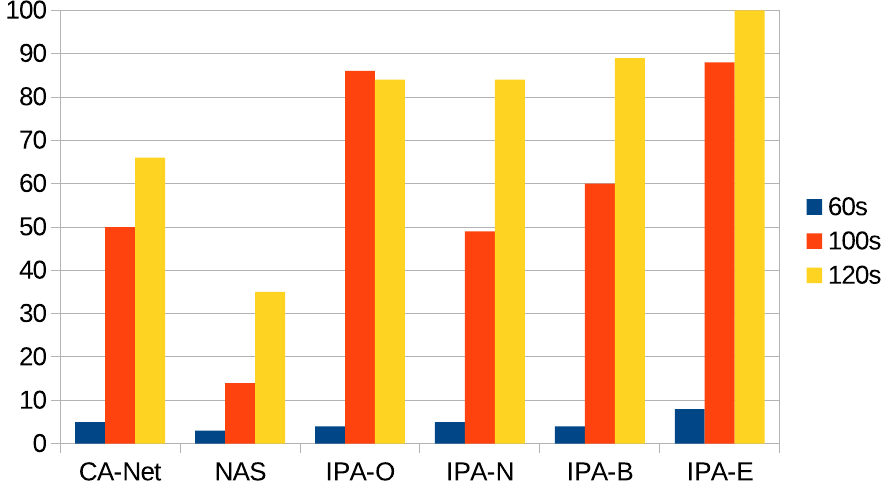
Figure 6. Percentage of successfully executed jobs for each deadline, out of the accepted